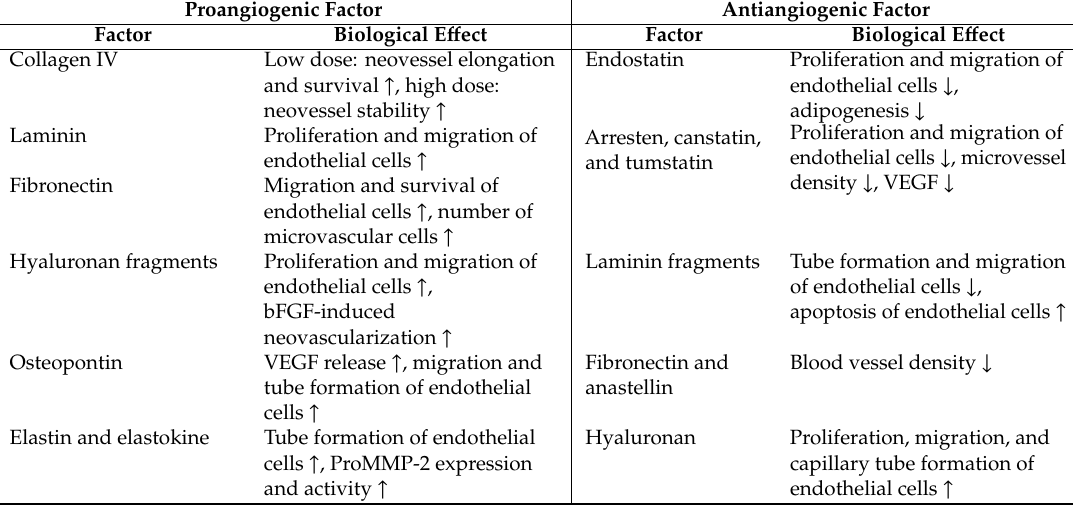
Table 2. ECM components involved in